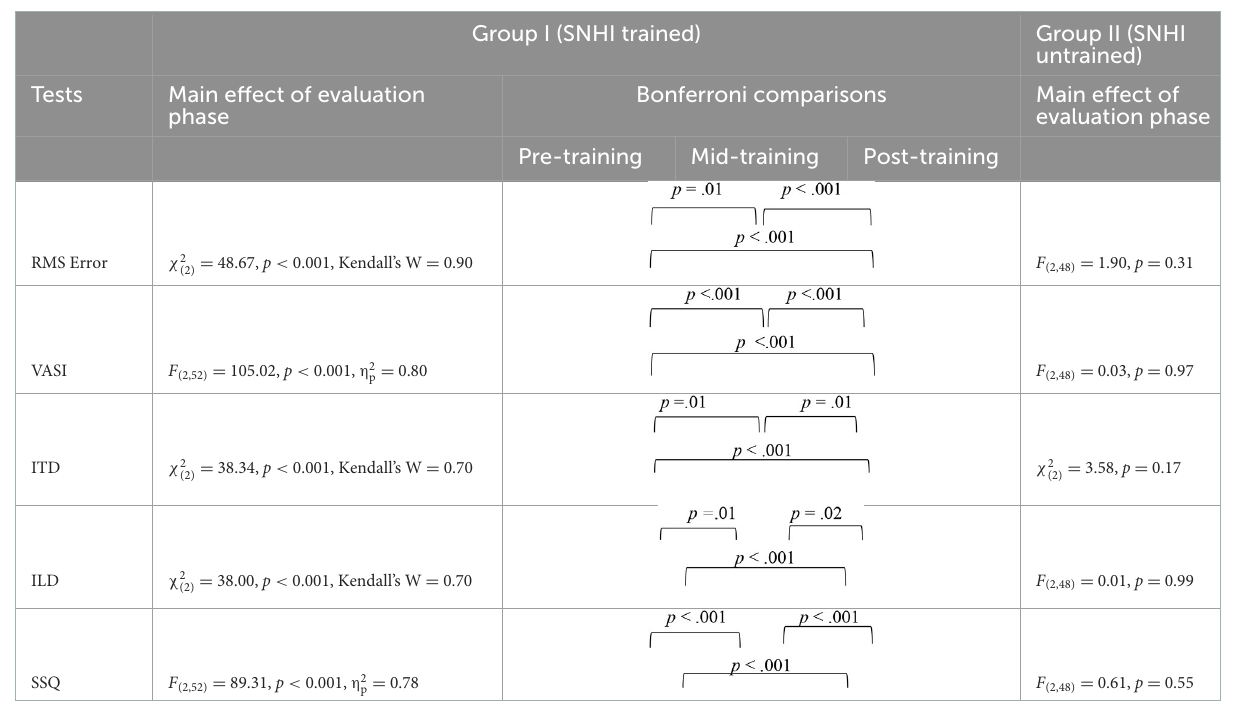
TABLE 1 Results of Friedman test for main effect of evaluation phase and follow-up adjusted Bonferroni’s pairwise comparisons for SNHI-trained and SNHI-untrained groups in each test of spatial